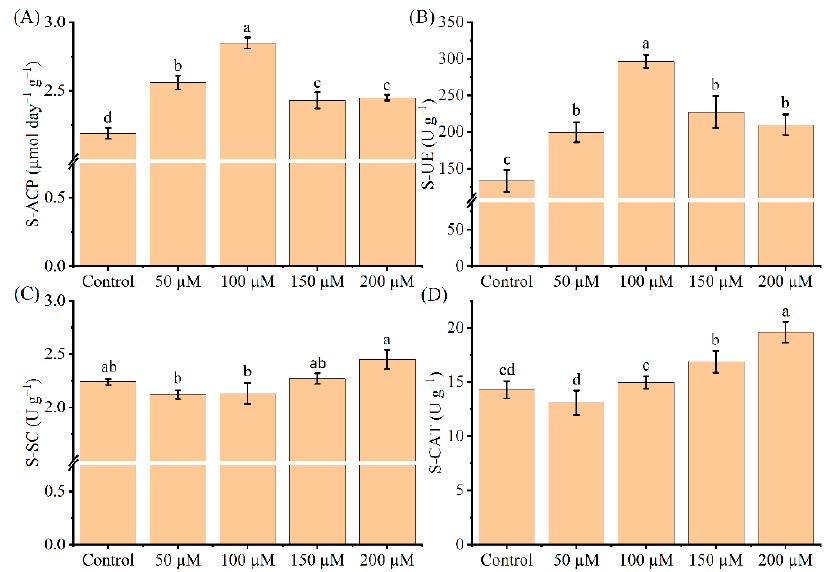
Figure 5. Effects of exogenous melatonin application on soil enzyme activities of Cd-stressed tea seedlings, including S-ACP ( A ), S-UE ( B ), S-SC ( C ), and S-CAT( D ). The data represent means ± standard deviations for three replicates. Different letters indicate groups that are significantly different at p < 0.05.